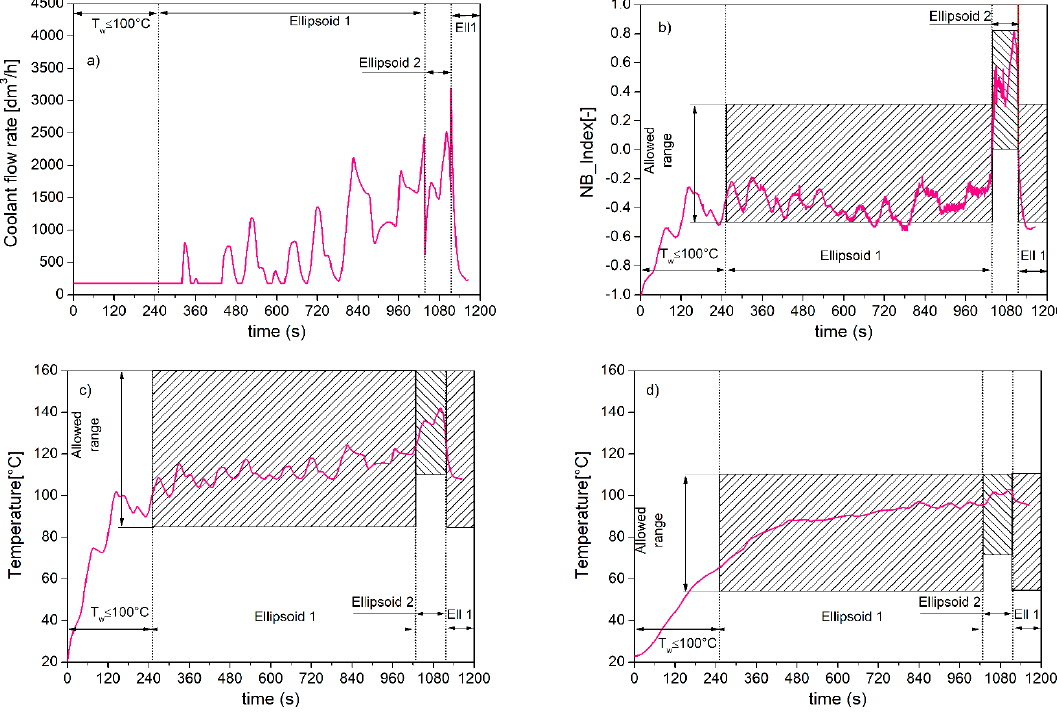
Figure 14. Coolant flow rate ( a ), NB_Index ( b ), and wall ( c ) and coolant ( d ) temperature for high boiling levels.